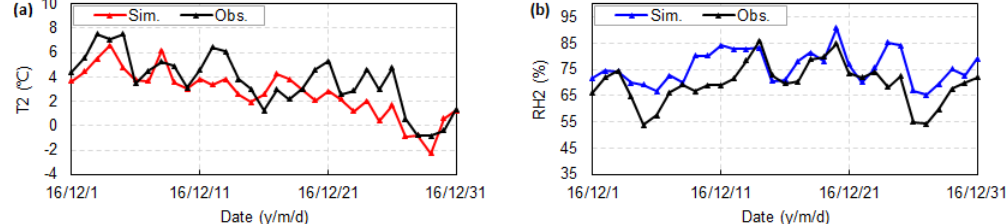
Figure 3. Time series plots of (a) daily average simulated and in situ 2m temperature (T2) and (b) simulated and in situ 2m relative humidity (RH2) at the Xi’an